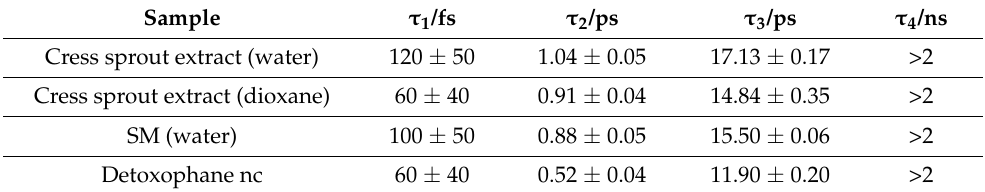
Figure 4. TEA spectra obtained for the bulk solution of Detoxophane nc photoexcited at 330 nm, shown as a false colour map ( A ). The same data are presented as a line plot of the mΔOD vs. probe wavelength at selected pump–probe delay times in ( B ). The EADS is shown in ( C ), with the 2 ns transients presented as an inset.